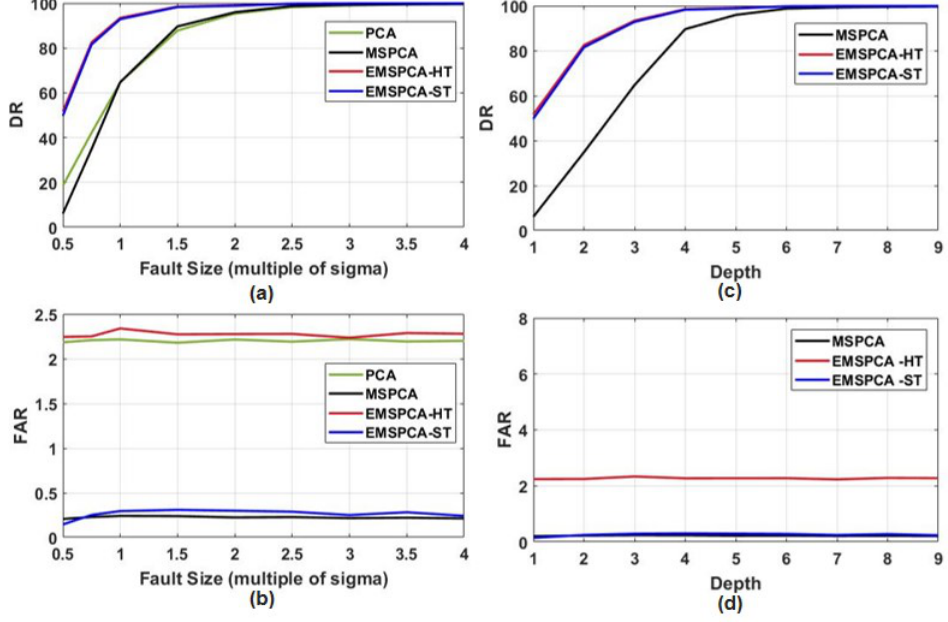
Figure 10. ( a ) DR and ( b ) FAR for MSPCA, EMSPCA-HT, and EMSPCA-ST across varying fault sizes and a fixed decomposition depth of 4; ( c ) DR and ( d ) FAR for MSPCA, EMSPCA-HT, and EMSPCA-ST across varying wavelet decomposition depths and a fixed unit fault